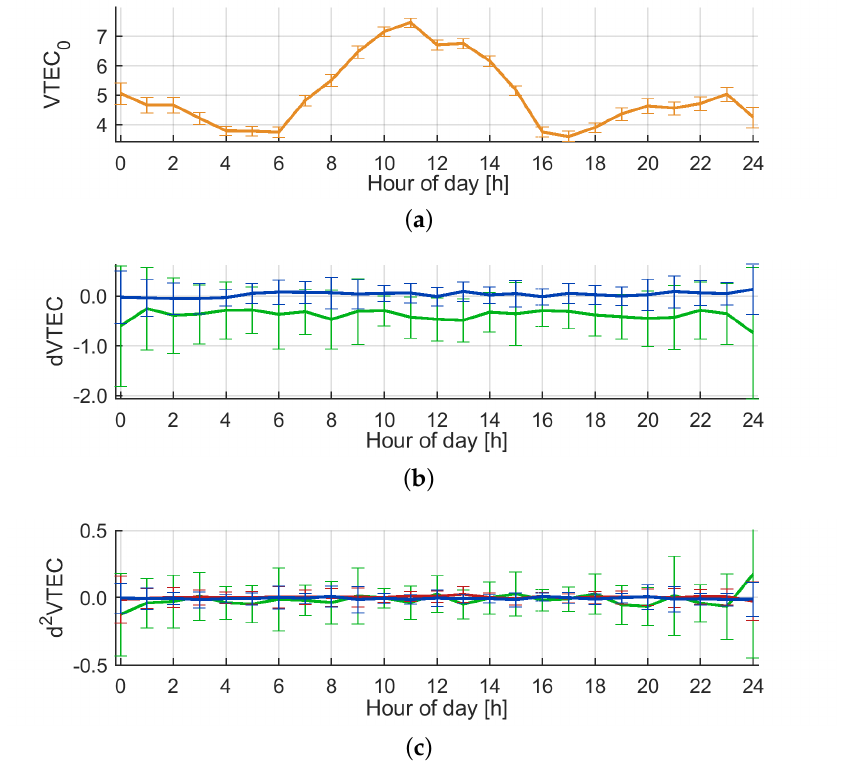
Figure 3. Behavior of the Regiomontan model parameters on doy 335, 2019: ( a ) The top panel depicts the behavior of VTEC 0 in TECU. The error bars illustrate the formal errors of the least squares adjustment magnified by the factor of 10 2 . ( b ) The middle panel depicts the behavior of the first derivatives of VTEC with respect to latitude (green) and longitude (blue) in TECU/rad. Formal errors are magnified by the factor of 10 3 . ( c ) The bottom panel depicts the behavior of the second derivatives of VTEC with respect to latitude (green), longitude (blue), and the mixed term (red) in TECU 2 /rad 2 . Formal errors are magnified by the factor of 10 3